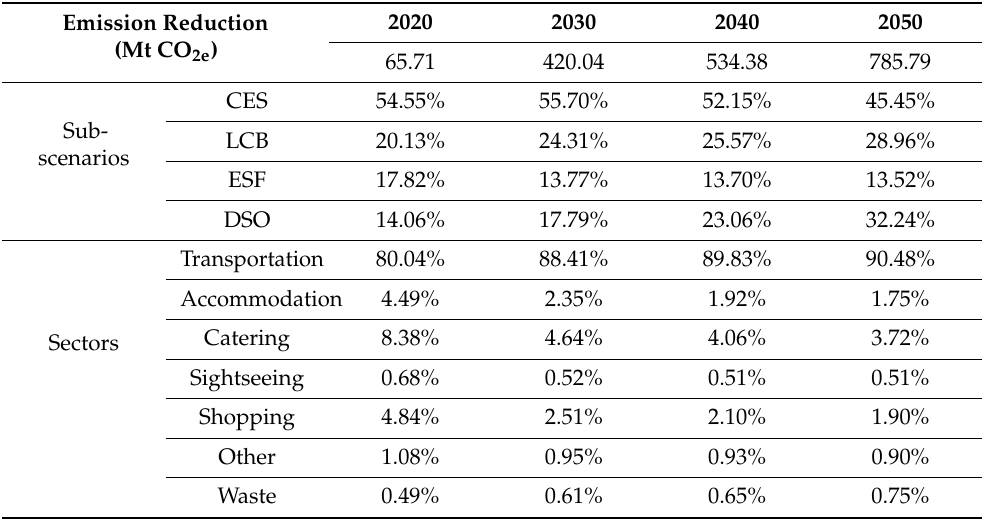
Table 5. Potentials and contribution percentage of GHG emission reductions in different sub-sce- narios and sectors.